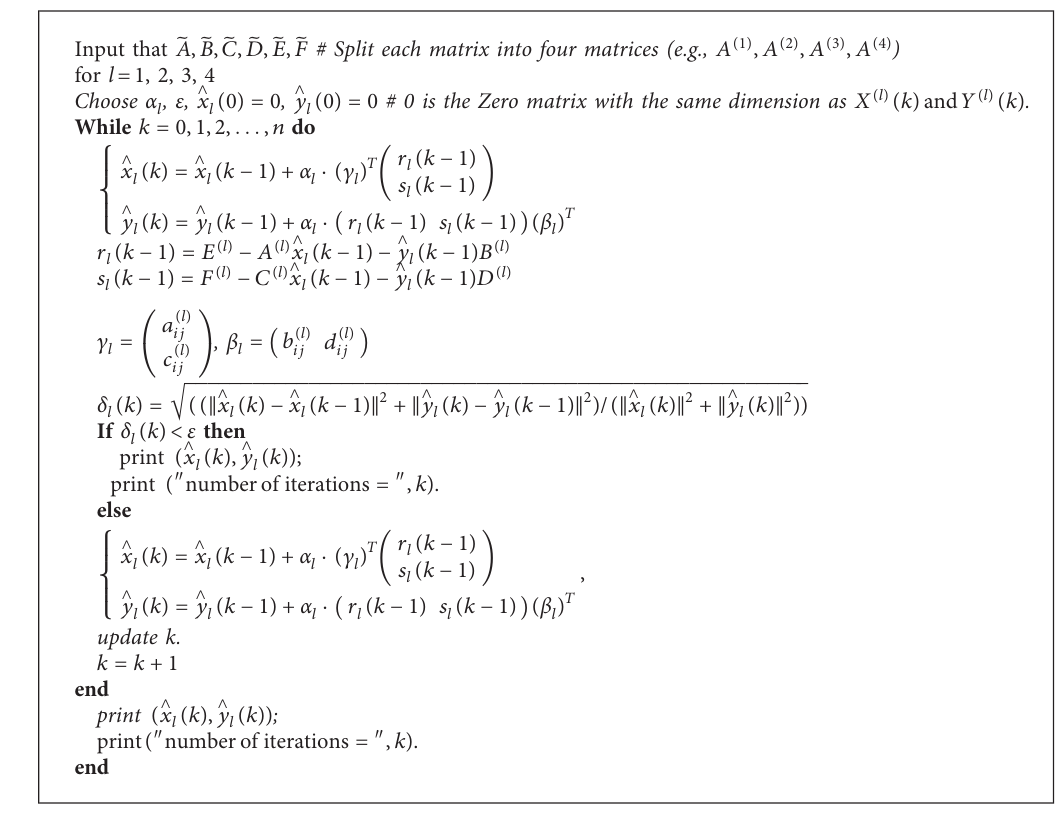
A LGORITHM 2: FGI algorithm for